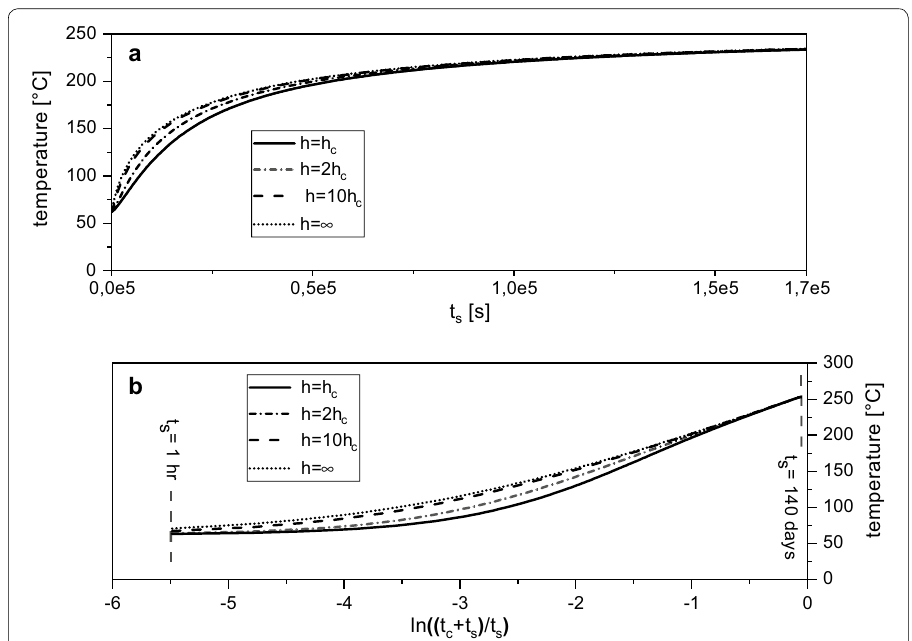
Fig. 3 a The change of BHT within a shut-in period of 20 days under four different heat transfer coefficients ( h ) in the borehole. b The Horner-plots of the four temperature curves shown in a [the x -axis value is the opposite of the Horner dimensionless time (Eq. 1), the minimum x -axis value of the temperature data on the curves corresponds to when t s 1 h, the maximum x -axis value corresponds to when t s =